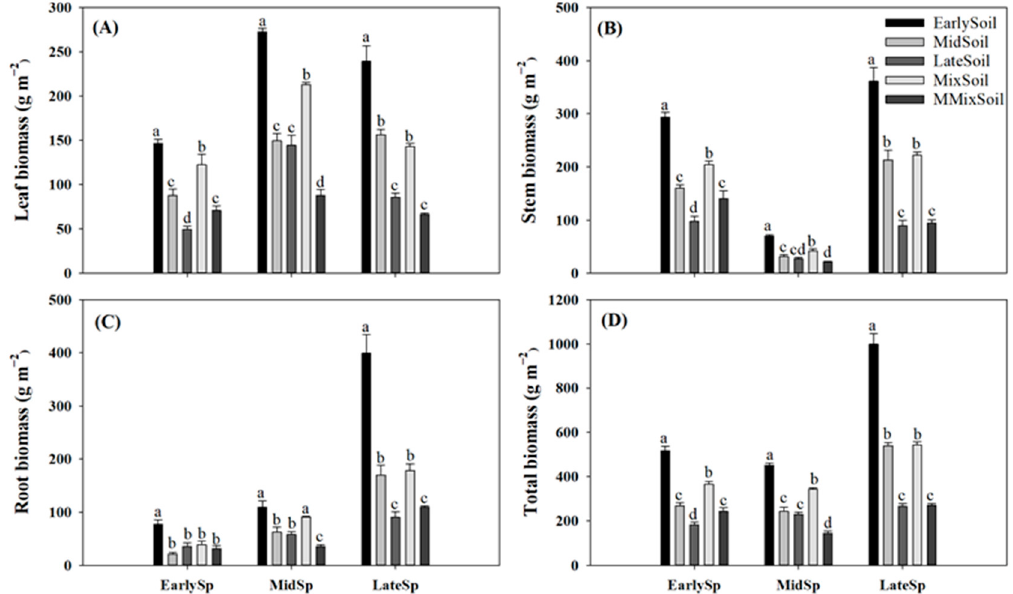
Figure 5. Effects of soil feedback on leaf ( A ), stem ( B ), root ( C ), and total ( D ) biomass in early-, mid-, and late-successional species. Error bars are standard errors ( n = 4). Different letters above the bars indicate significant differences at p < 0.05.